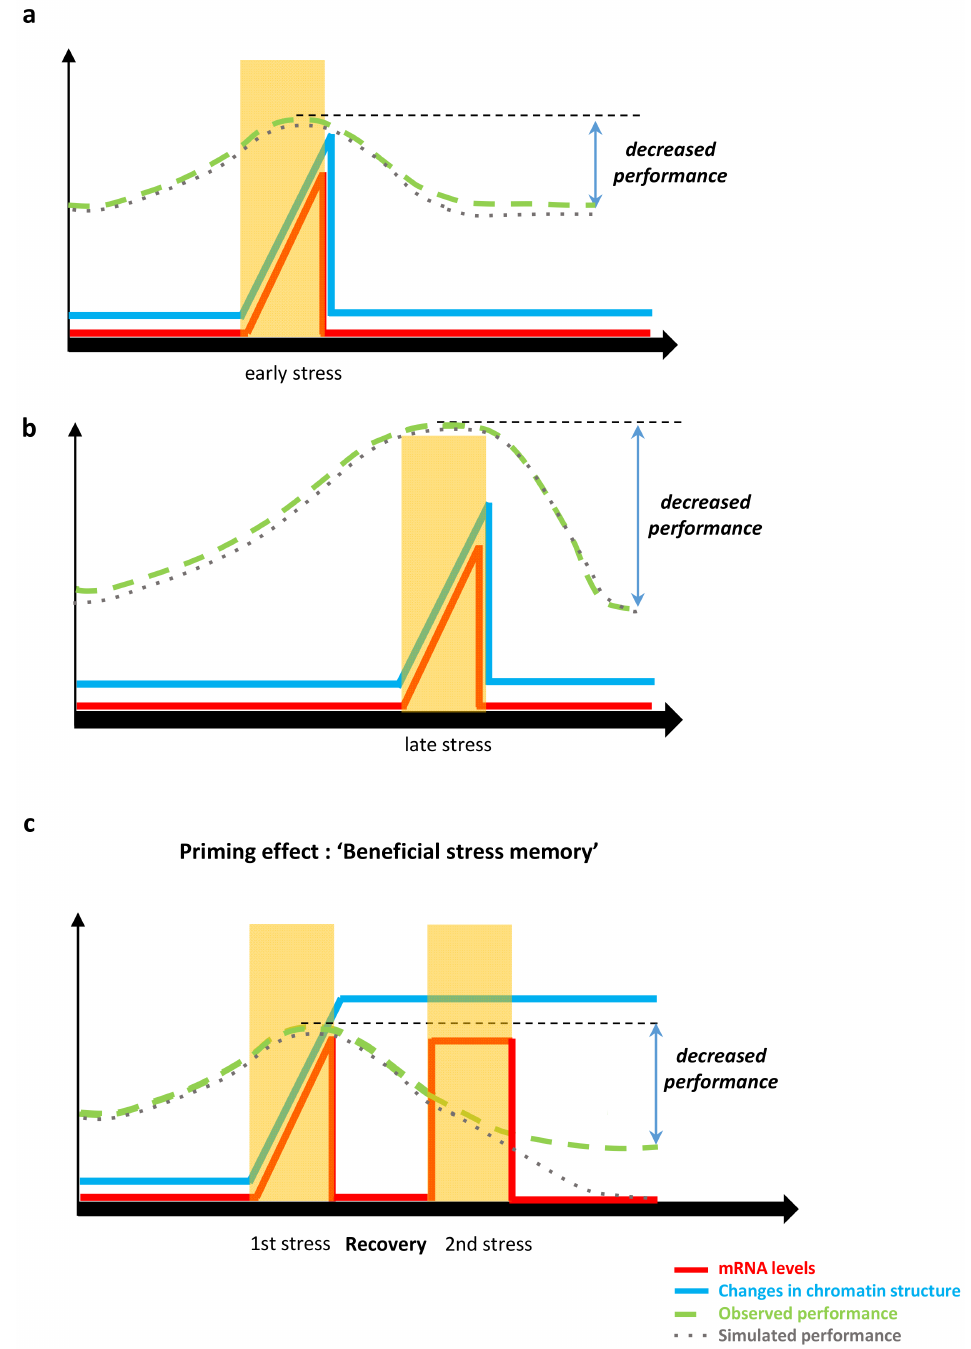
Figure 3. Illustration of the above-raised modelling questions when simulating stress response (measured through plant performance) in a two-stressing-event sequence when a priming effect from the first stressing event is observed. Graphs ( a ) (green dotted line) and ( b ) (green dotted line) display negative effect of a single stressing event (early ( a ) and late ( b )) on plant performance along with associated molecular events (levels of RNA transcripts and chromatin structure changes). Graph ( c ) (green dotted line) shows how priming alleviates the negative effect of the first stress exposure on the plant performance through the maintenance of chromatin changes, allowing faster (sometimes more efficient) gene transcription and hence plant adaptive response. Simulated performance under the two-stressing-event sequence (graph ( c ), grey dotted line) might result in the addition of the two decreases that followed each single event if the model does not take into account the stress memory effect. Adapted from